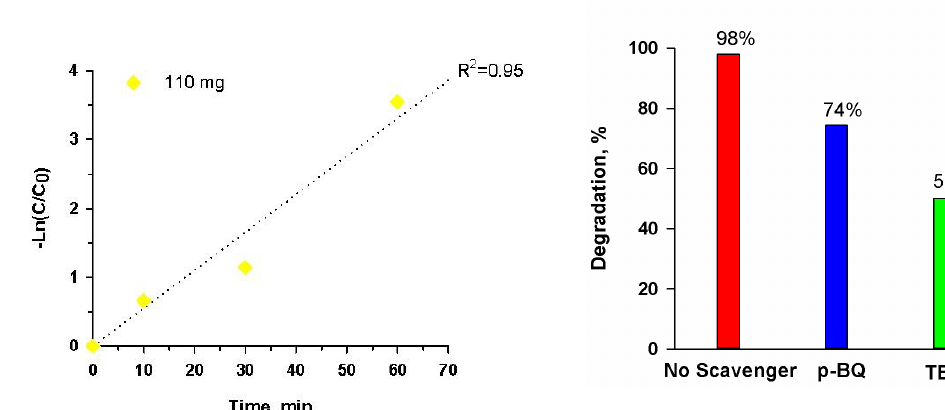
Fig. 13 Kinetics of MB removal in the photocatalytic reaction over Fe-ZIF-8 in the optimum conditions.